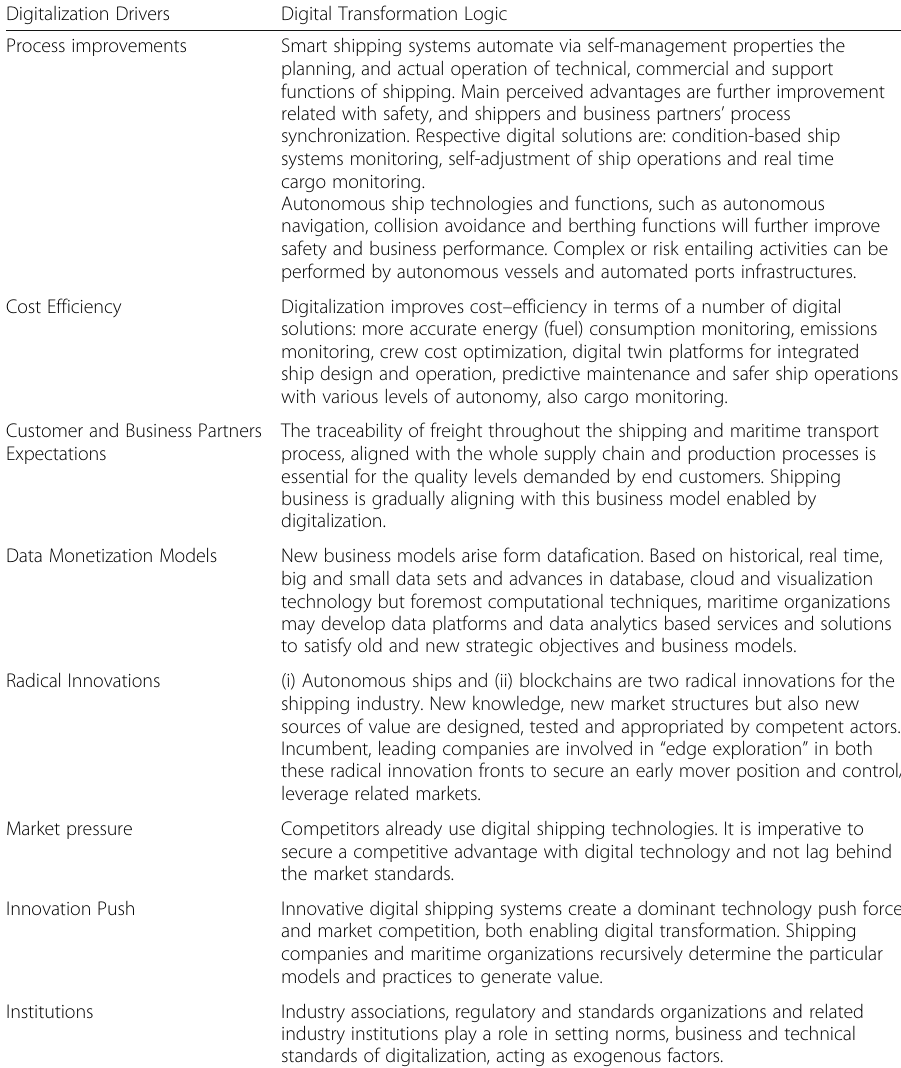
Table 2 Drivers of Shipping Digitalization vis-à-vis Digital Transformation